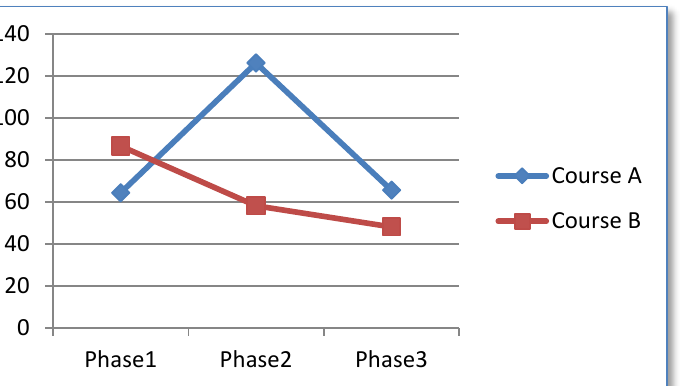
Figure 4. Average number of behavioral interactions with peers for each phase of the semester for the two